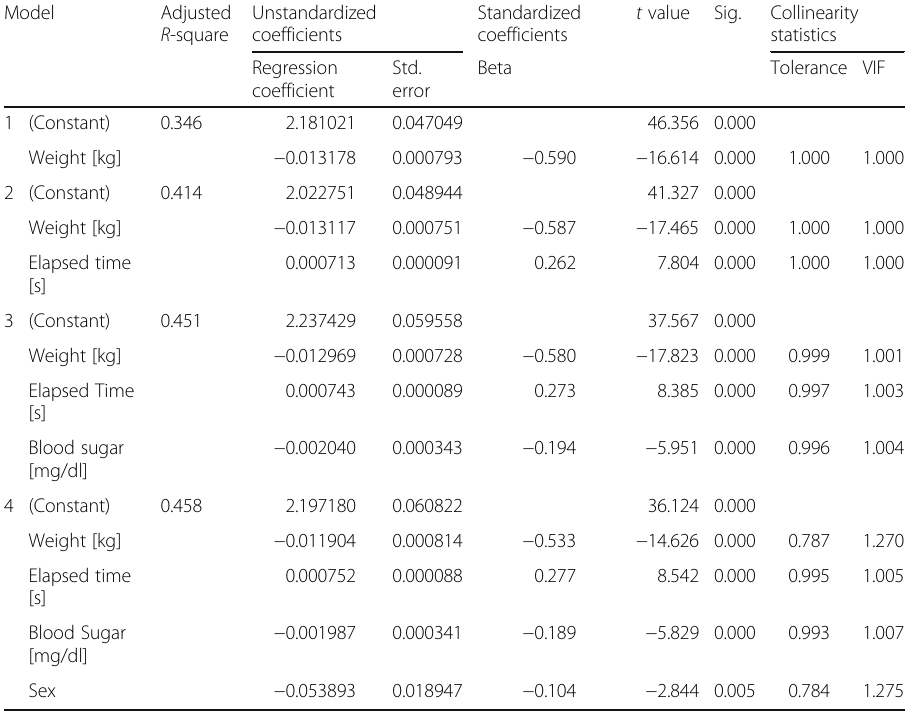
Table 4 Stepwise multiple regression analysis models